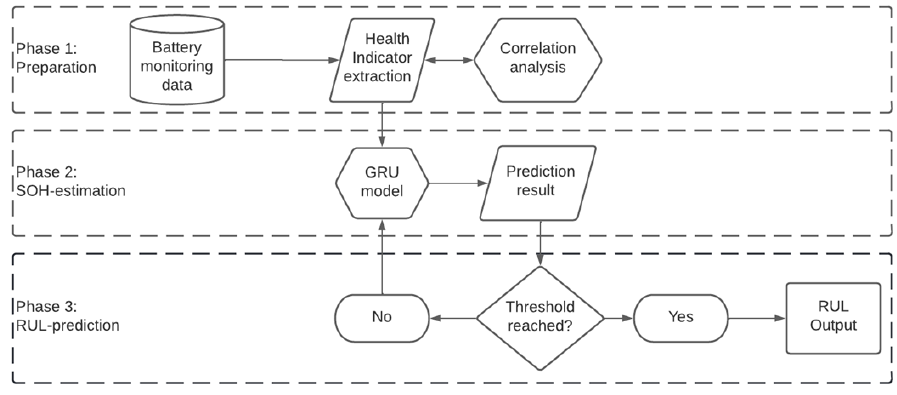
Figure 5. The RUL prediction model.